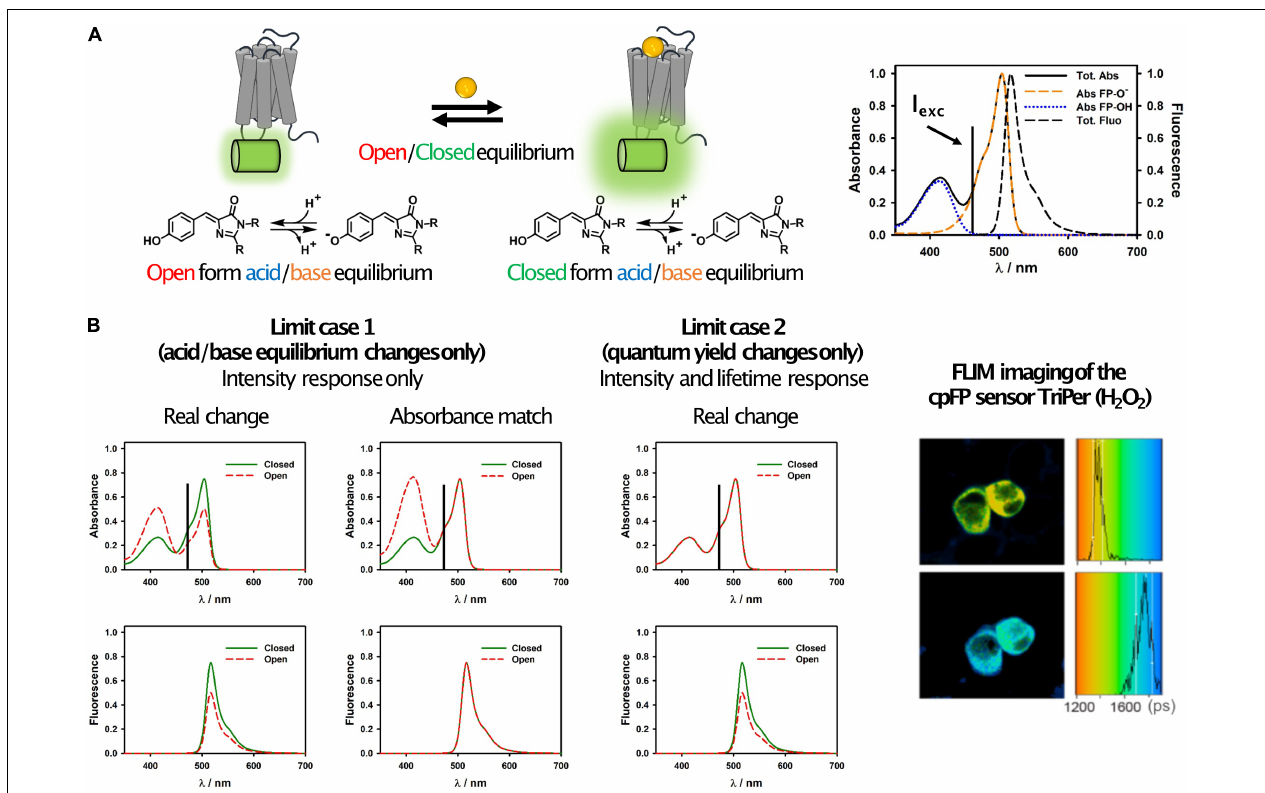
FIGURE 2 | Simplified photophysical description of cpFP sensors with emphasis on FLIM. (A) Schematic representation of the equilibrium occurring in GPCR sensors (left) and of their spectroscopic properties (right). It can be observed how the absorption spectrum is actually the sum of two bands, one due to the protonated (acid) form of the chromophore and one to the deprotonated (basic) one. The latter is also the only emissive form in most cpFPs used in sensors. This is certainly true if the sensor is excited at longer wavelengths, as shown in these examples, where only the basic form absorbs. (B) Representative spectral changes for the two limit cases described in the text (left), and FLIM images and histograms of RINm5f cells expressing the cpFP sensor TriPer before (right, top) and after (right, bottom) exposure to 0.2 mM H 2 O 2 (reproduced without modifications from Melo et al., 2017; under Creative Commons license: http://creativecommons.org/licenses/by/4.0/). Possible candidates for FLIM can be identified by looking at the changes of the absorption and fluorescence spectra of the sensors upon analyte binding. If only the acid/base equilibrium changes, but not the quantum yield of the basic form, then no lifetime change is expected